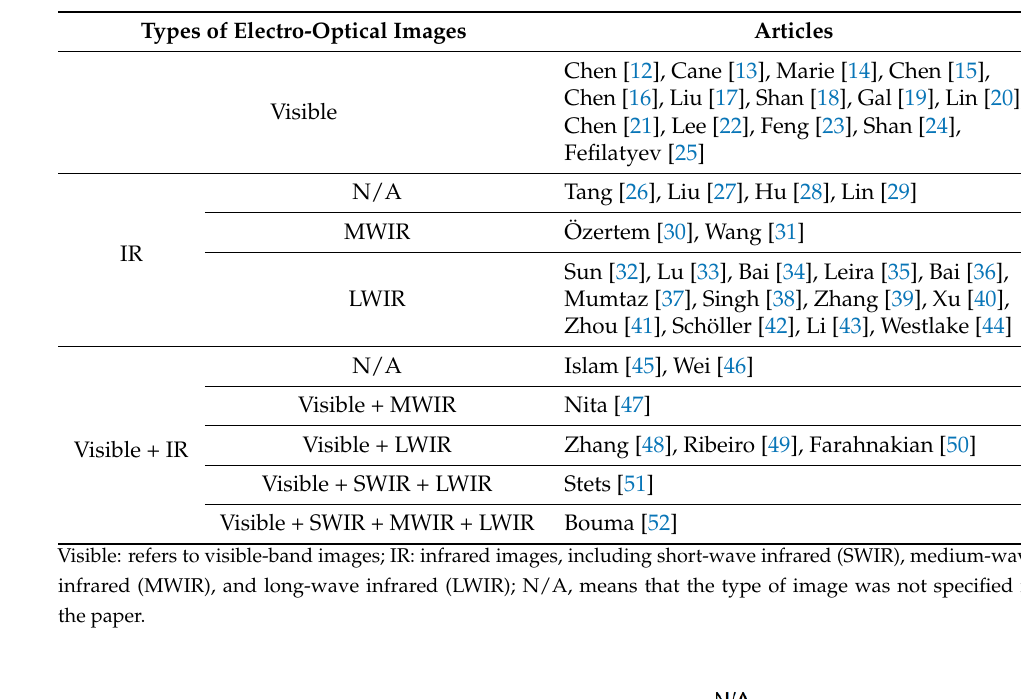
Table 1. Types of electro-optical images commonly used in ship detection.